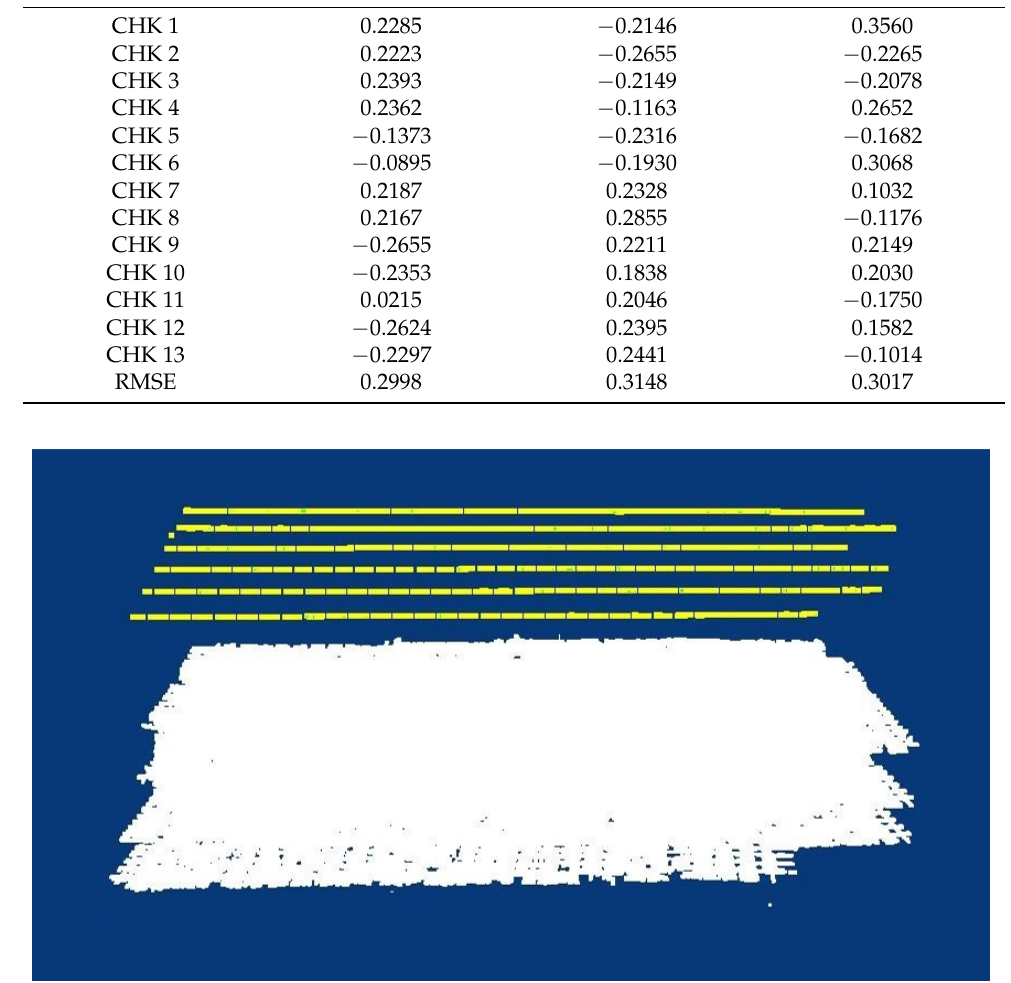
Figure 12. Sparse Point Cloud After the Fourth